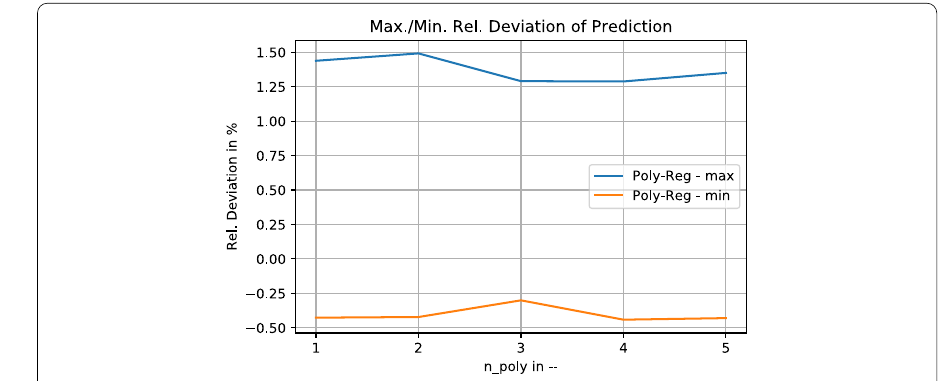
Fig. 15 Rel. Error for brakedisk-models using up to fifth polynomial degree